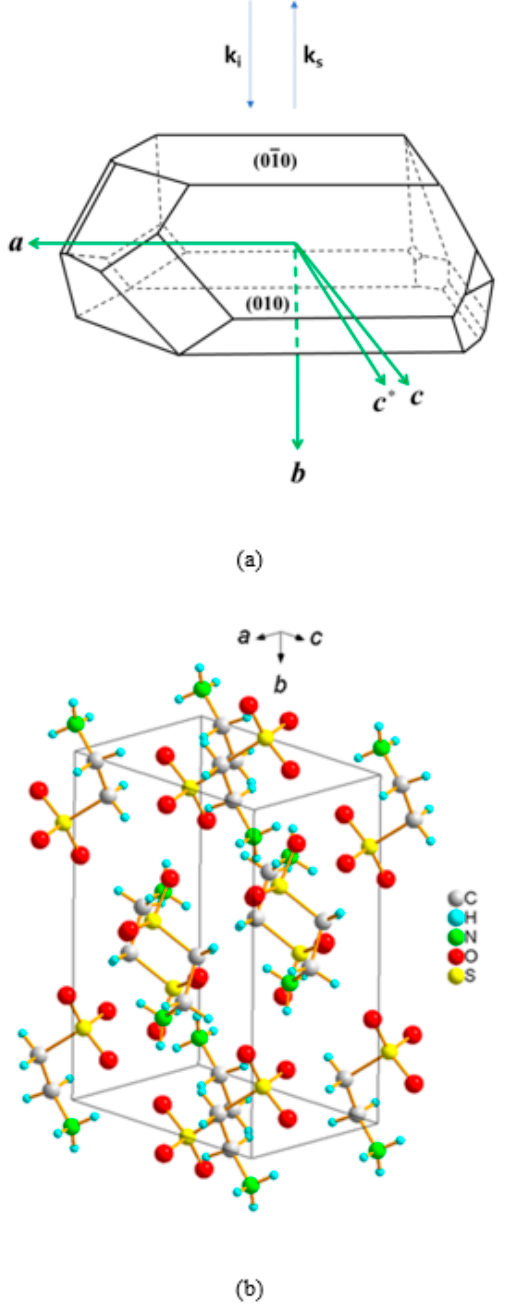
Figure 1. ( a ) The crystal morphology along with major crystallographic surfaces and axes. Two vectors k i and k s denote the wave vectors of the incident and the scattered lights, respectively. c * direction is perpendicular to both a and b axes. ( b ) The crystallographic unit cell of the taurine single crystal.